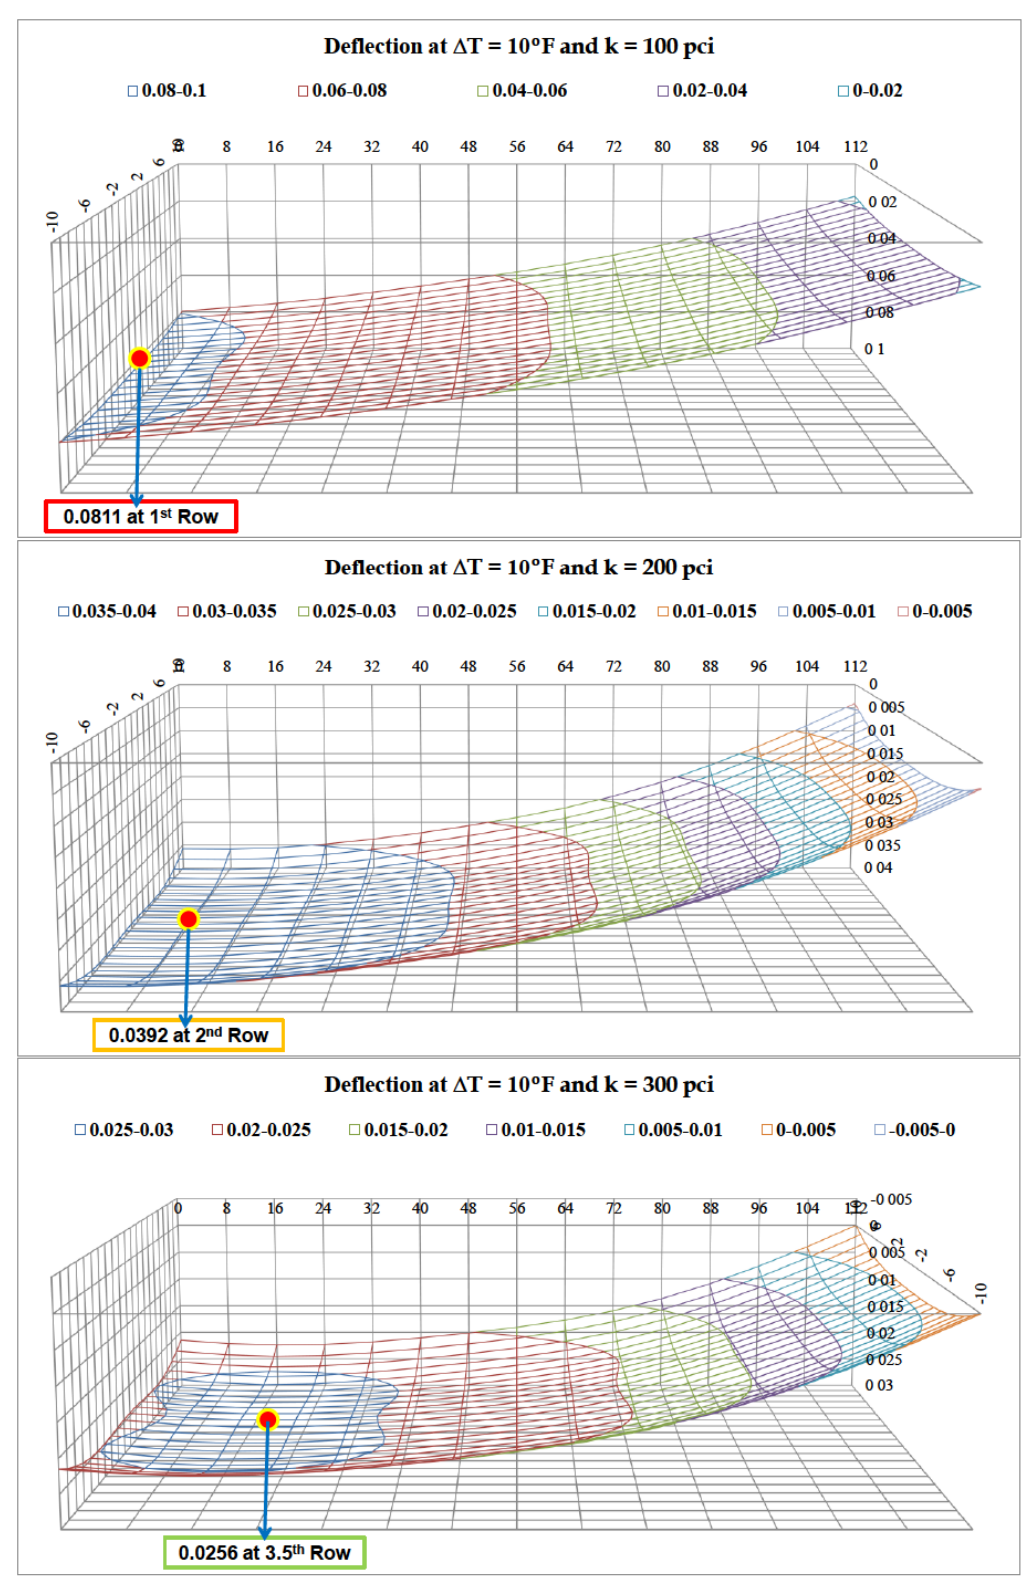
Figure 13: Deflection at the same ∆ T = 10 ∘ F with different